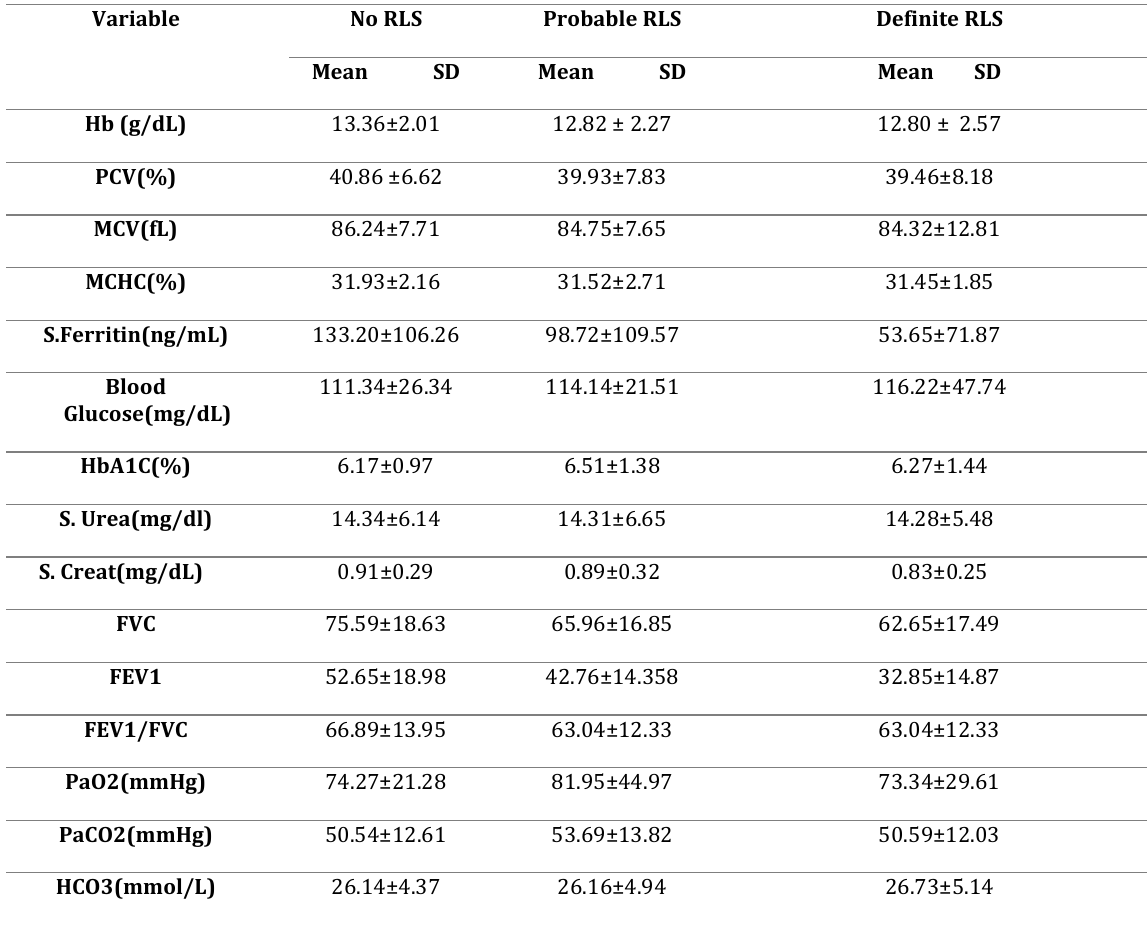
Table 6 : Comparison of mean of laboratory studies, spirometry and arterial blood gas readings between patients with and without